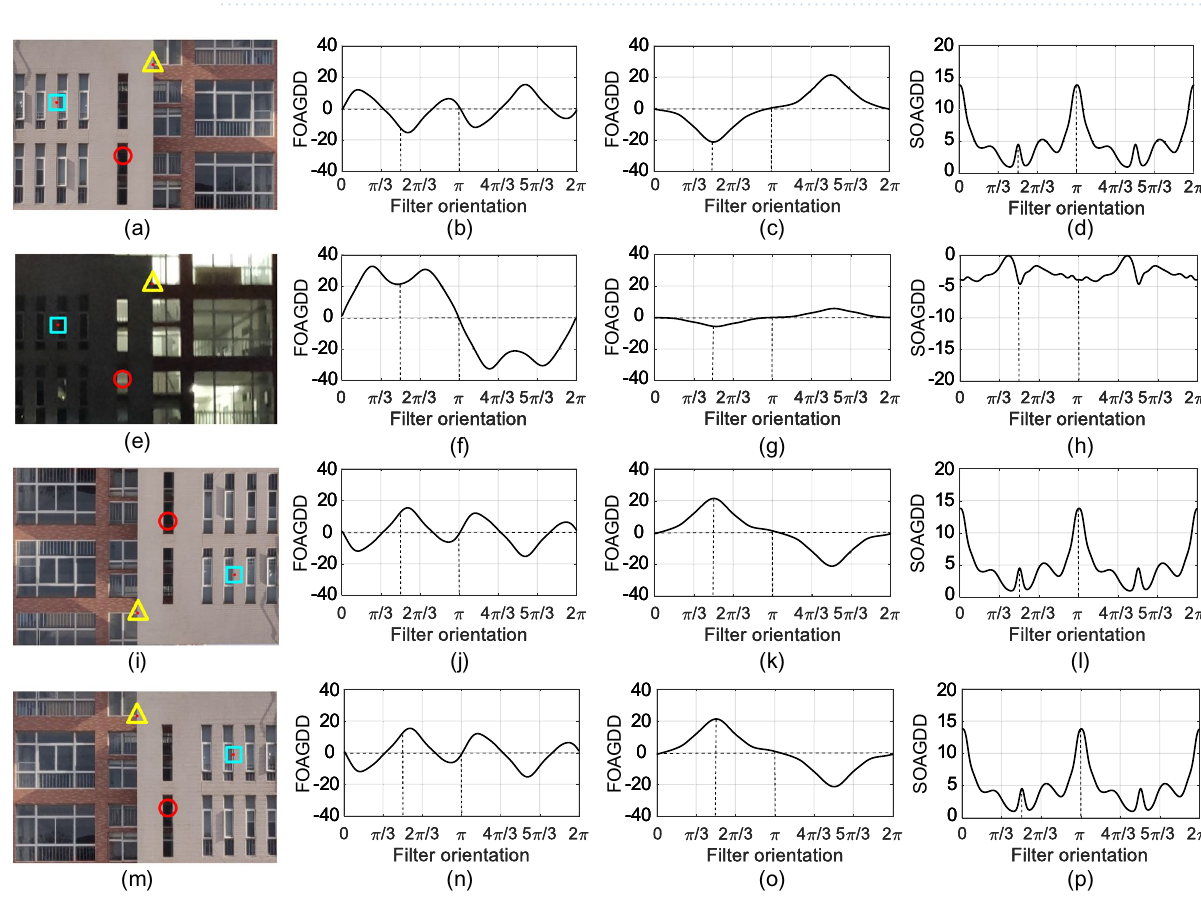
Figure 2. Examples of the FOAGDDs at a corner (marked by ‘ (cid:31) ’)and an edge point (marked by ’ (cid:31) ’) and the SOAGDDs at a blob (marked by ‘ ’) at the same location under different imaging (cid:31)